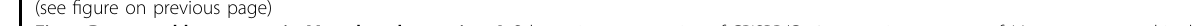
Fig. 1 Decreased bone mass in Mtu1 knockout mice. A Schematic representation of CRISPR/Cas9 target site at exon 1 of Mtu1 gene, as used in this study. The resultant truncated 11 aa non-functional protein caused by frameshifting insertion in Mtu1 is shown in the diagram. B , C Genotyping of Mtu1 knockout mice by Sanger sequencing and agarose gel electrophoresis. The PCR product size for genotyping is 417bp in Mtu1 + / + mice and 417bp/452bp in Mtu1 + / − mice. D Western blot analyses show that BM-MSCs isolated from Mtu1 + / − have lower Mtu1 expression levels. E μ CT images of the femurs of wild- type and Mtu1 de fi cient male mice at 6 weeks, 12 weeks, and 48 weeks. Scale bars: 1mm. In the analysis of the trabecular bone and architecture, the following parameters were calculated: F Bone volume per tissue volume (BV/TV); G Trabecular thickness (Tb.Th); H Bone surface to bone volume (BS/BV); I Trabecular spacing (Tb.Sp); J Trabecular bone mineral density (BMD). n = 6 per group. The region of interests (ROI) for trabecular parameters calculation were chosen at the central of medullary cavity with cylinders (1mm in diameter, 1mm in height) at 1mm away from epiphyseal line. K H&E staining and L ALP staining of distal femoral sections of 4 weeks old mice. Scale bars: 100 μ m. M The relative levels of positive ALP staining area in the yellow dotted line at the femur were quanti fi ed using Image J. n = 5 per group. * P <0.05; ** P <0.05; *** P